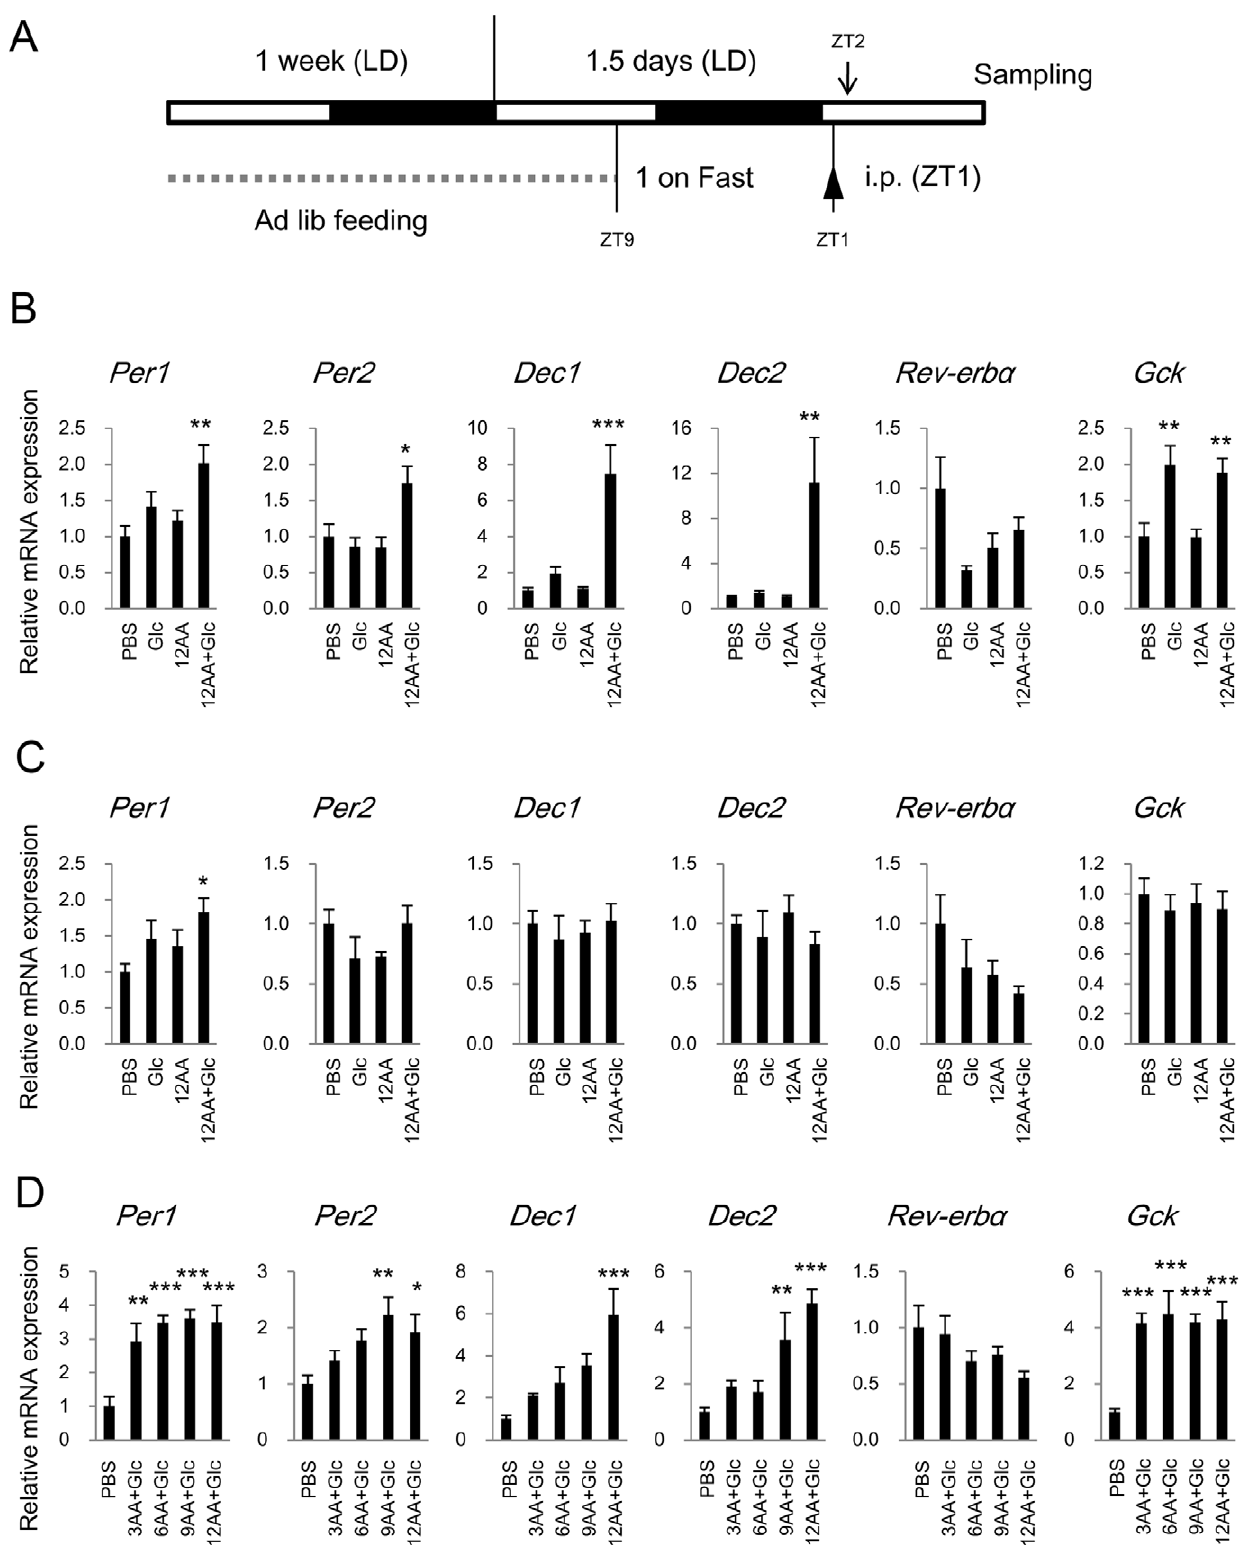
Figure 4. Rapid response in clock gene and Gck expression in liver and lung after intraperitoneal injection of nutrients. (A) Experimental design. BALB/c mice were fasted overnight then intraperitoneally injected with nutrients (Glc: glucose, AA, amino acids; see Materials and methods) or PBS (control) at ZT1. All animals were sampled at ZT2. (B–D) Expression of clock gene and Gck mRNA in liver (B and D) and lung (C) is shown as means 6 SEM relative to control group (n=8, * p , 0.05, ** p , 0.01, *** p , 0.001; vs. control; Dunnett’s test).